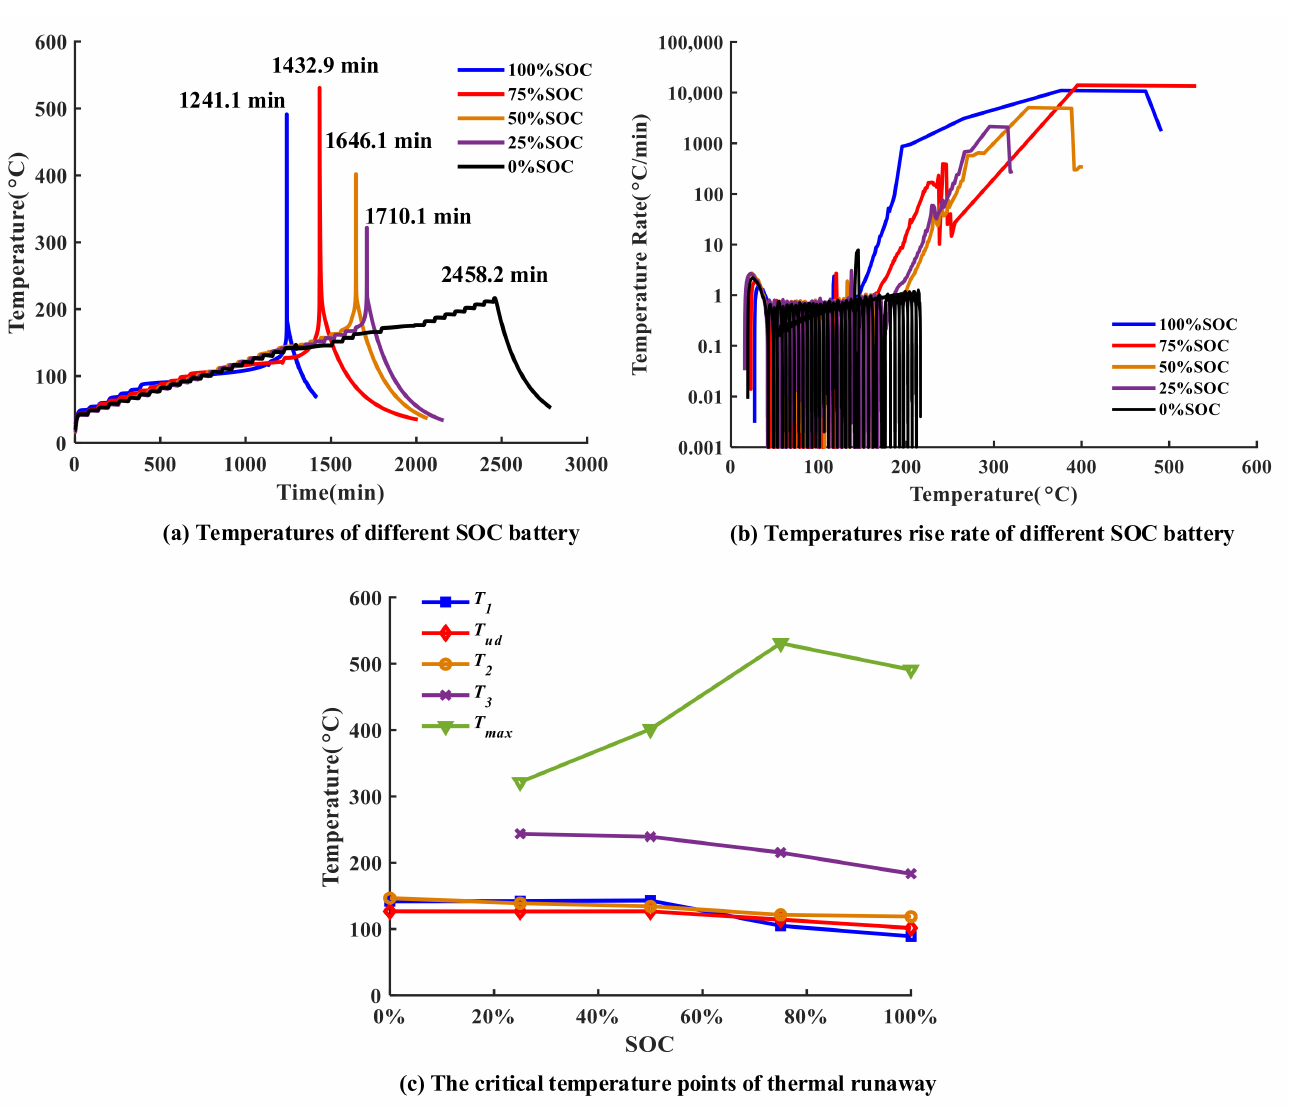
Figure 7. The comparison of TR of different SOC